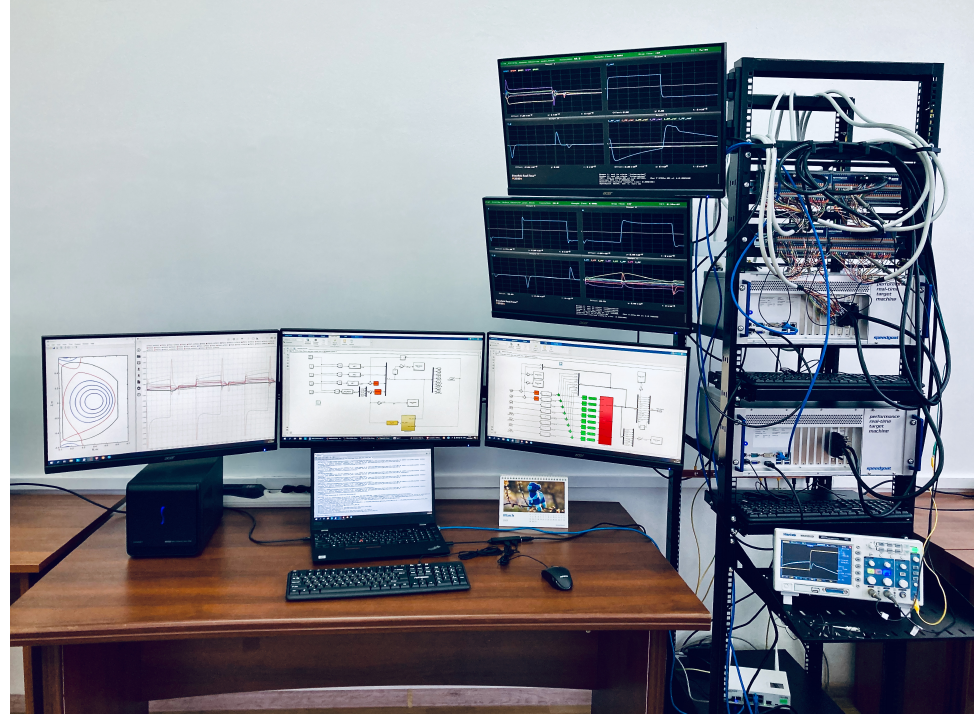
Figure 14. Real-time test bed for plasma control in tokamaks. The test bed consists of two Speedgoat performance real-time target machines that are connected in feedback: one computer plays the role of the controlled plant model and the other one is the MIMO controller (https://www.ipu.ru/press- center/62866, accessed on 21 December